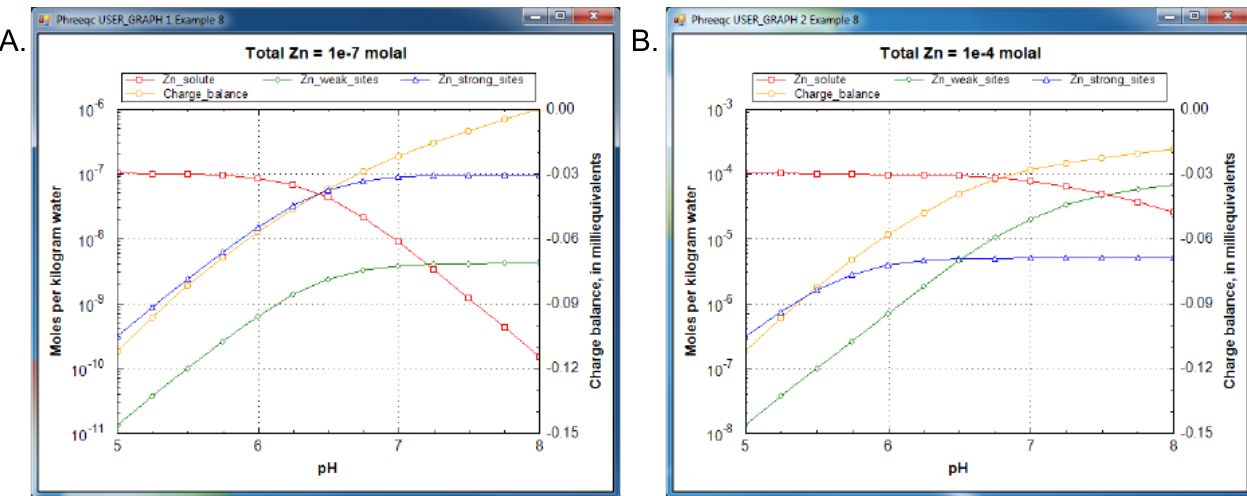
Figure 9. Distribution of zinc among the aqueous phase and strong and weak surface sites of hydrous iron oxide as a function of pH for total zinc concentrations of (A) 10 -7 and (B) 10 -4 molal. The secondary Y axis shows the charge balance of the solution, which (in the model) becomes negative at decreasing pH because protons are sorbed on the surface, or, at the higher Zn concentration and high pH, because Zn +2 is